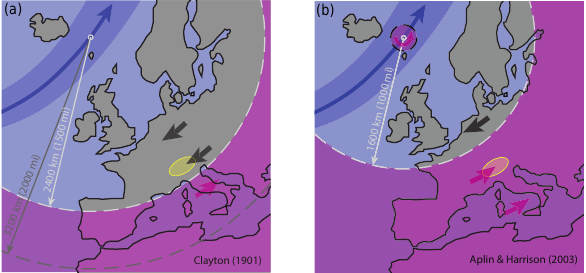
Figure 1. Theoretical effects of penumbral shading on wind direc- tion. Wind directions around the center of the umbra (east of Ice- land) according to the theory of Clayton (1901) (a) and Aplin and Harrison (2003) (b) , drawn for the time of maximum occultation over the Swiss Alps (yellow area). The eclipse trajectory is shown with a blue arrow, and the umbral path (100% occultation) is shown with a blueish band. The diagram shows the position of greatest eclipse with its center indicated by a gray